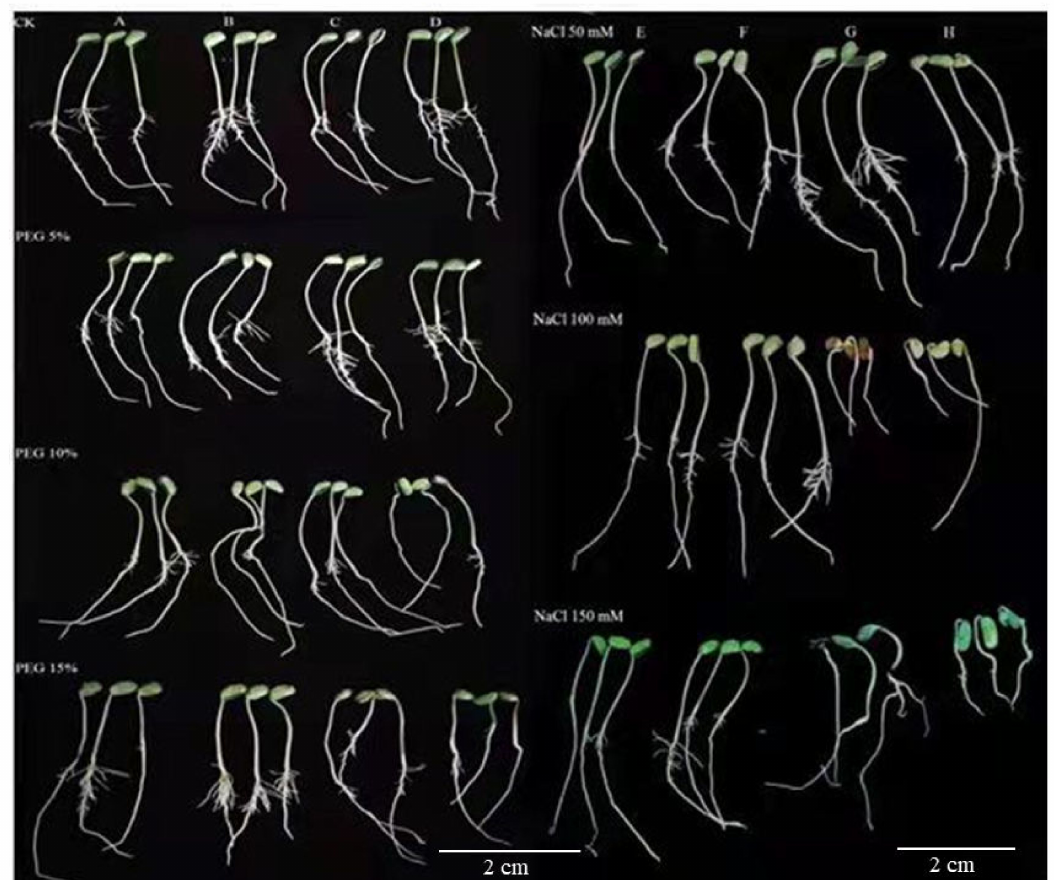
Figure 2. Seed germination of four soybean cultivars grown under different drought and salinity